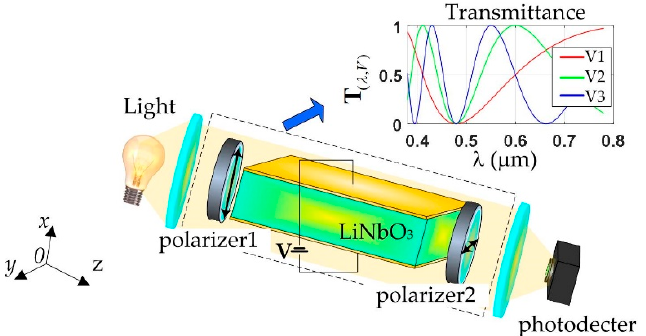
Figure 1. Schematic of spectrometry using a LiNbO 3 electro-optical transmittance coding